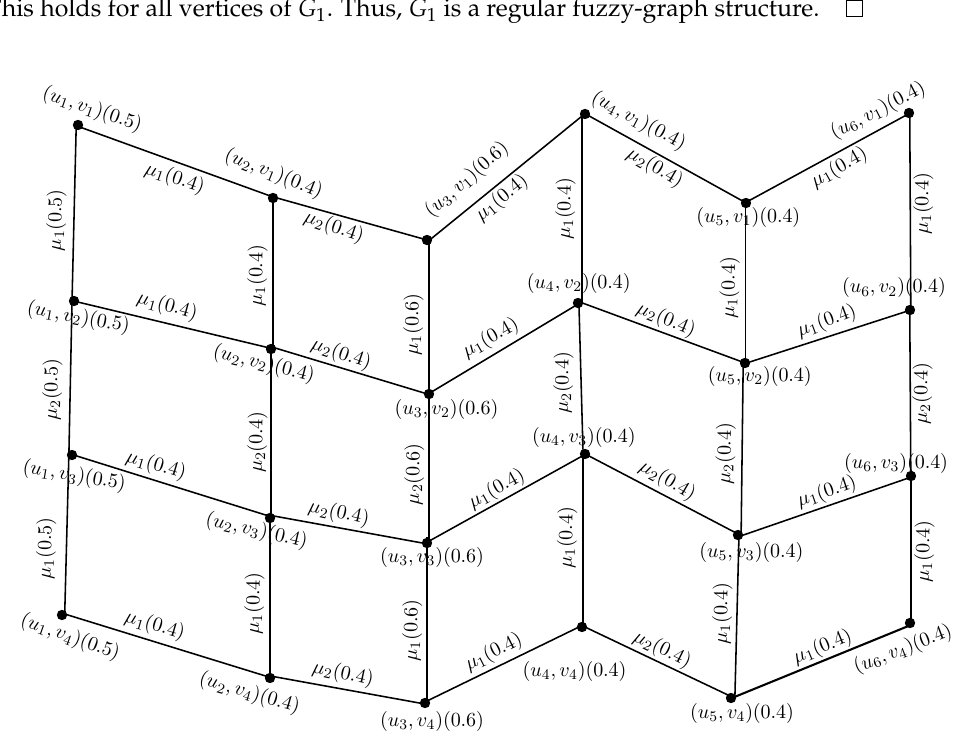
-regular and µ ′′ 1